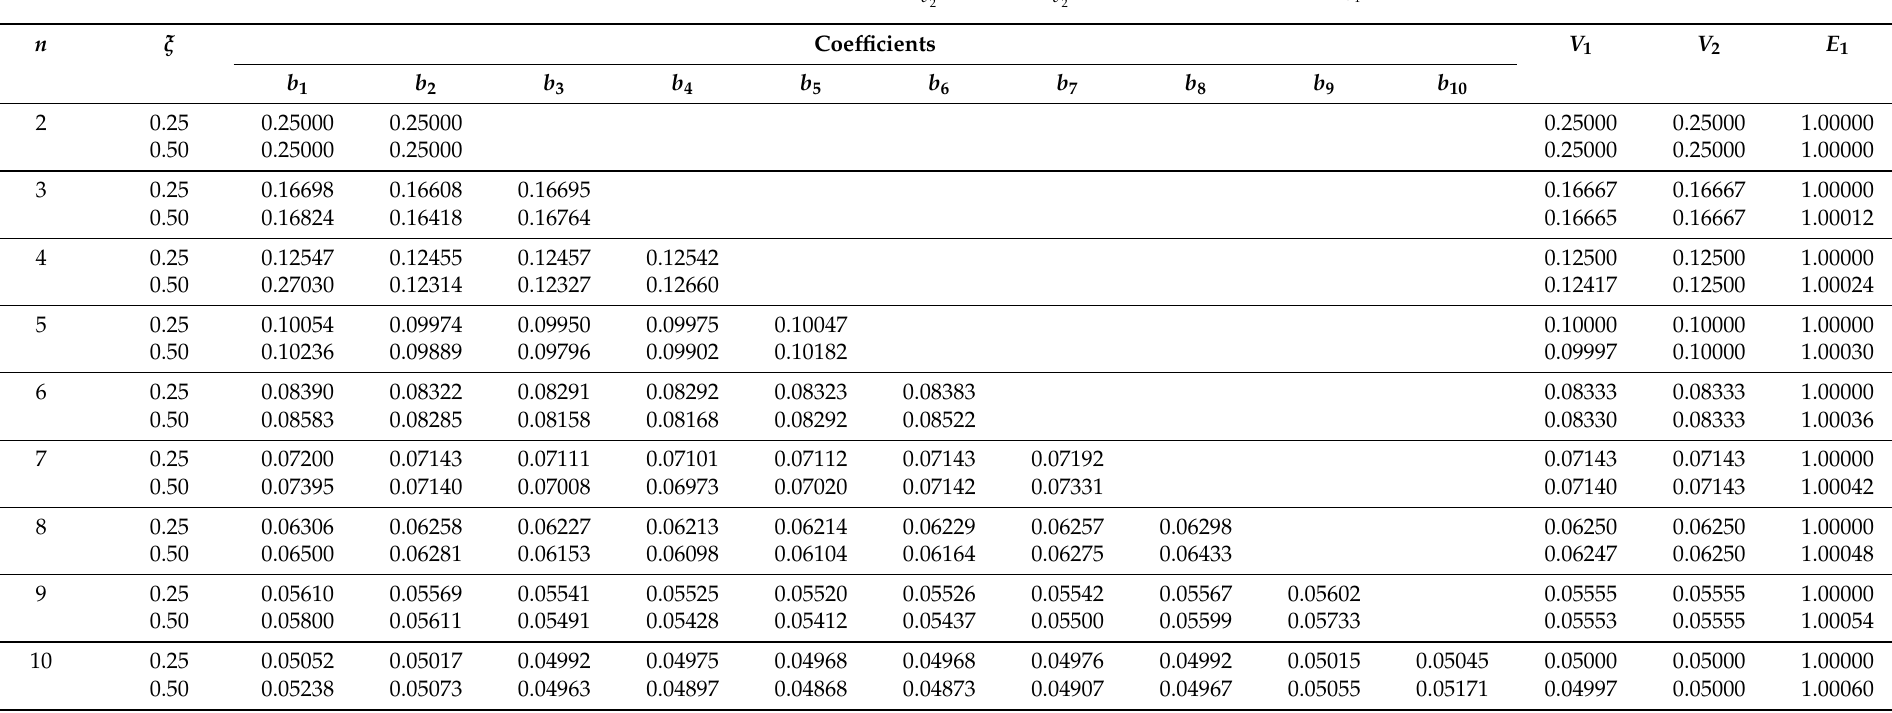
of ˜ σ 2 relative to ˆ σ 2 V 1